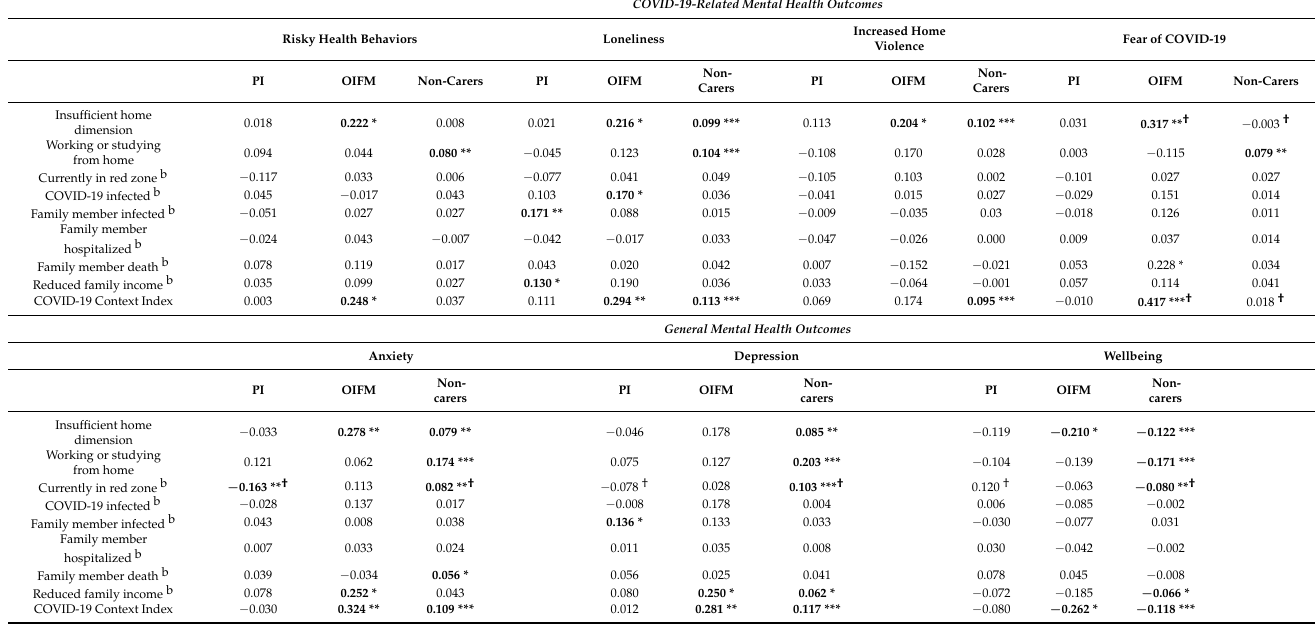
Table 3. Correlations between COVID-19 context variables and the mental health outcomes in the parental illness group (PI), other ill family member (OIFM) group, and non-carer